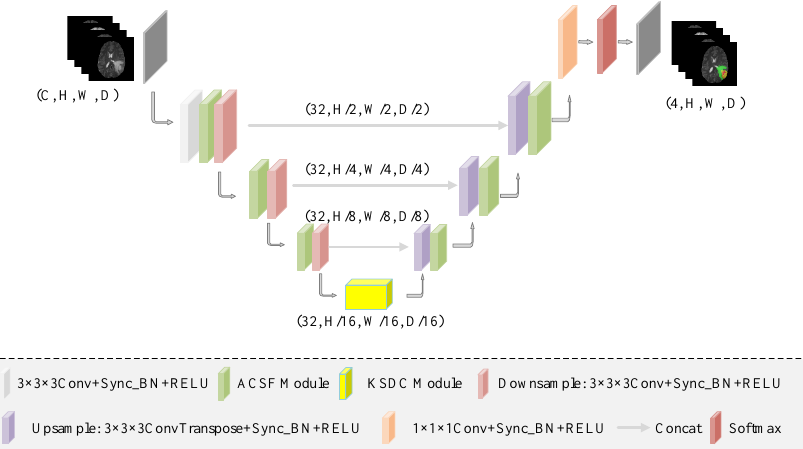
Figure 1. The complete network structure of MVKS-Net. C denotes the channel number of feature maps, H denotes the height of feature maps, W denotes the width of feature maps, and D denotes the depth of feature maps, respectively. We design a network with an encoding–decoding structure, which contains a hierarchical multi-view module based on axial–coronal–sagittal fusion (ACSF) convolution to provide complementary view features and kernel-sharing dilated convolution (KSDC) to obtain parameter-consistent convolution kernels with different receptive